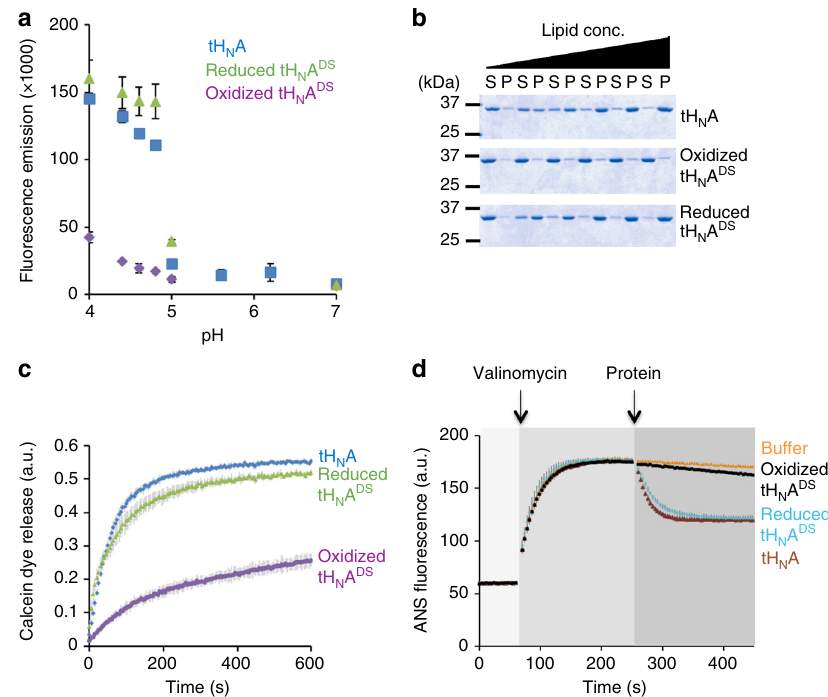
Fig. 3 Modulating the conformation of the BoNT-switch using an engineered disul fi de bond trapping. tH N A DS was analyzed by four independent assays: a ANS binding; b liposome association: liposome co-sedimentation was conducted by incubating the WT tH N A or tH N A DS with different concentrations of liposomes containing 20% DOPS and 80% OBPC. Supernatant (S) and pellet (P) fractions were analyzed by SDS-PAGE. Quanti fi cation of protein band intensities are shown in Supplementary Fig. 12. Uncropped images of gels are shown in Supplementary Fig. 13; c calcein dye release; and d membrane depolarization assay. 5 mM TCEP was added for the reaction of reduced tH N A DS and no reducing agent was used for wild type or oxidized tH N A DS . The data are presented as mean ± S.D., n =